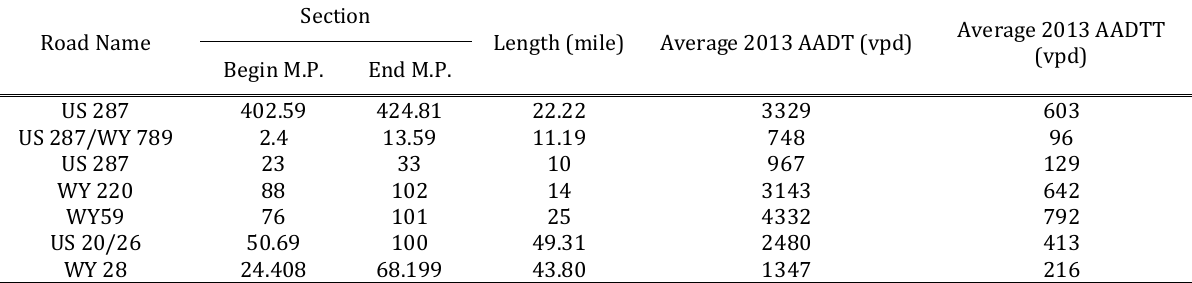
Table 1: Traffic Counts in the Headlight Sign Sections in